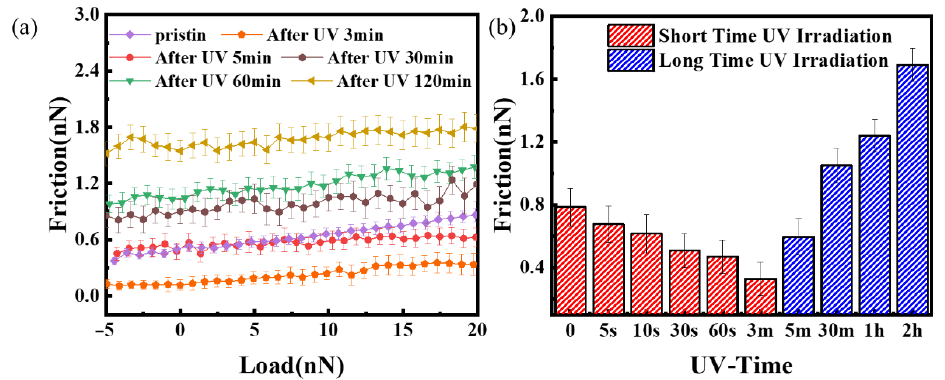
Figure 9. ( a ) Friction comparison of 1 nm thick graphene after UV long-term vacuum irradiation; ( b ) friction comparison of graphene with the same thickness after UV vacuum irradiation at different times under 20 nN loads. The red area can be classified as short-time irradiation reduction in friction, while the blue area is long-term irradiation aging.